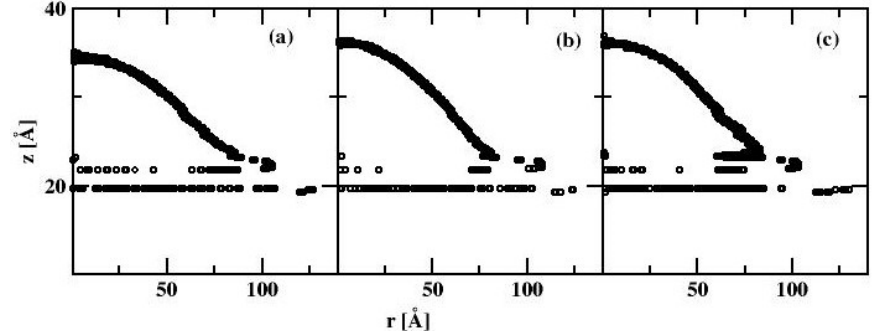
Figure 14. The spherical water droplet contour for the water–alkane–SiO 2 system with 8000 molecules of water calculated at three hydrocarbon surface concentrations, CHY DR = 0.59 ( a ), 1.47 ( b ), and 2.78 ( c ) molec/nm 2 . The circles denote the position of the water density profile with value 0.5 ± 0.03 g/cm 3 .